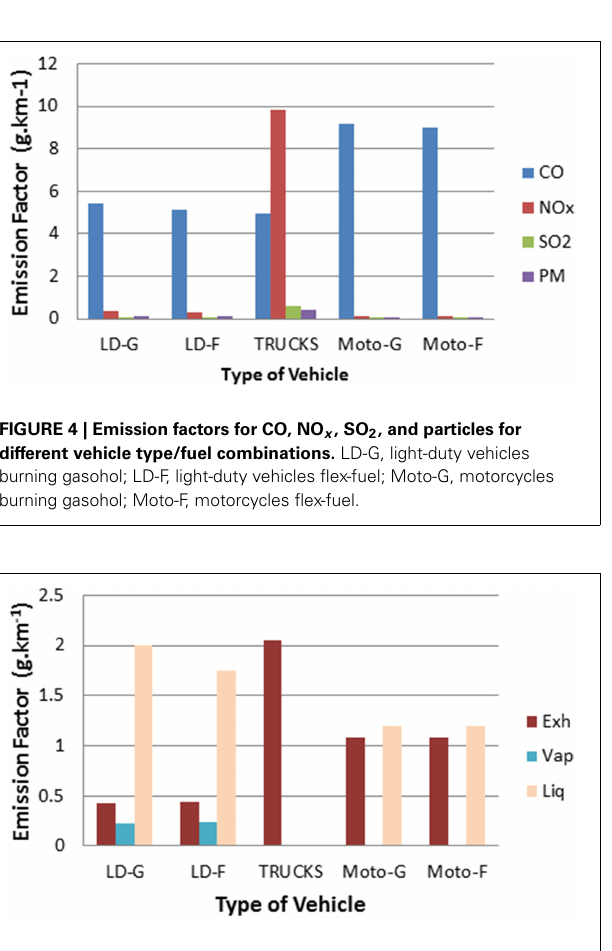
FIGURE 5 | VOC emission factors from exhaust, evaporative and liquid emissions. Exh, exhaust; Eva, evaporative; Liq, liquid; LD-G, light-duty vehicles burning gasohol; LD-F, light-duty vehicles flex-fuel; Moto-G, motorcycles burning gasohol; Moto-F, motorcycles